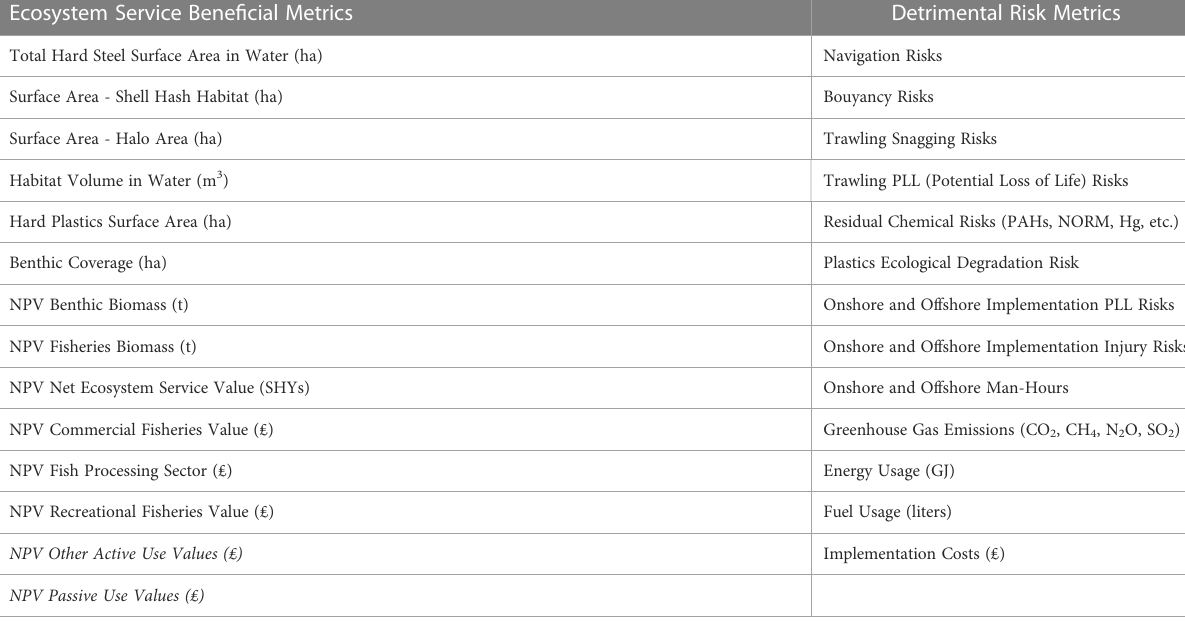
TABLE 1 Example Metrics Used for Offshore Decommissioning Applications of